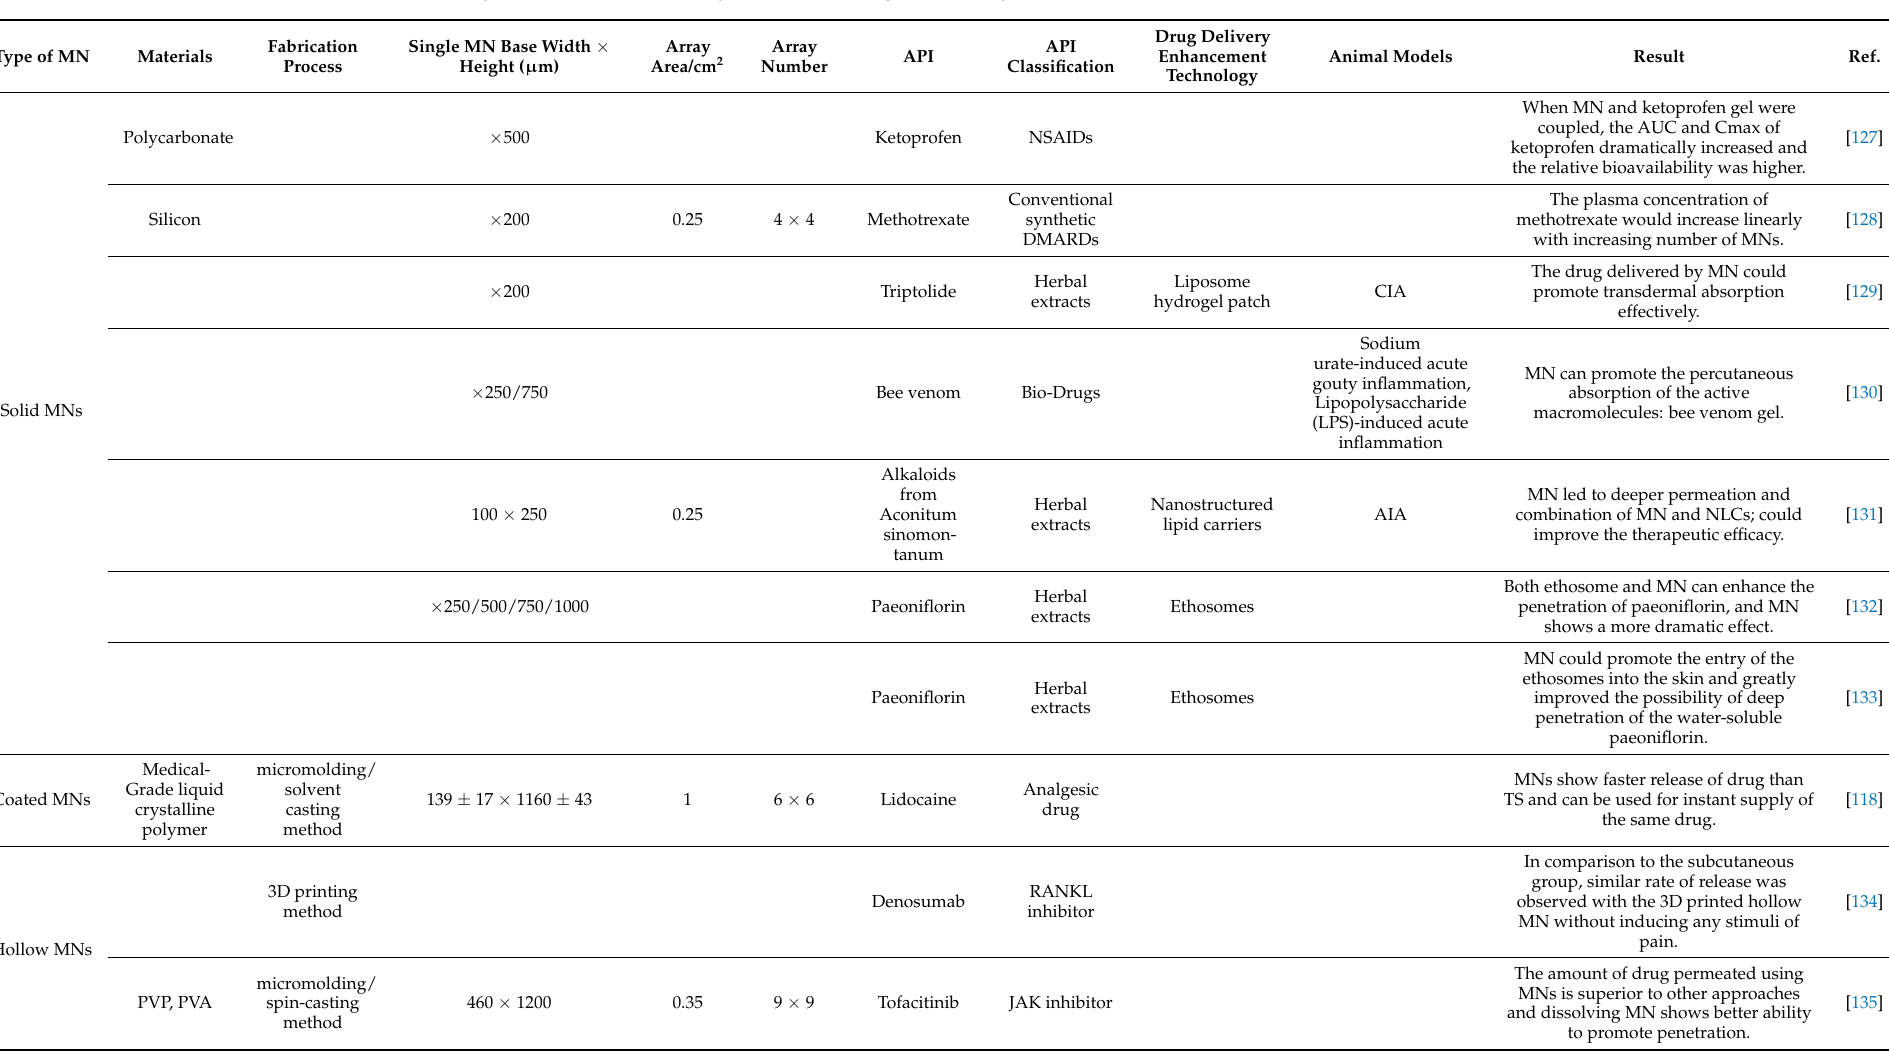
Table 4. Laboratory studies of MN delivery of arthritis drugs in recent